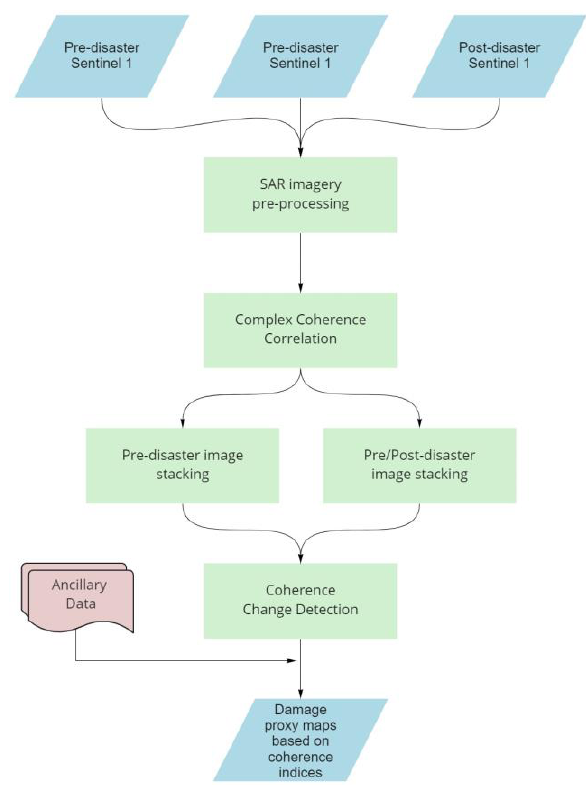
Figure 2. An overview flowchart of the processing steps used in this study wherein two-pairs of SAR images with short baselines were used to generate intensity correlation images which are then compared for change detection.